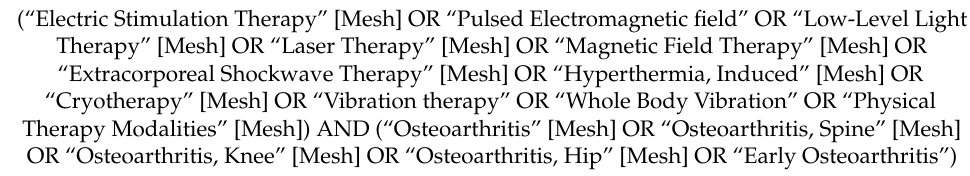
Table 1. Search Strategy.